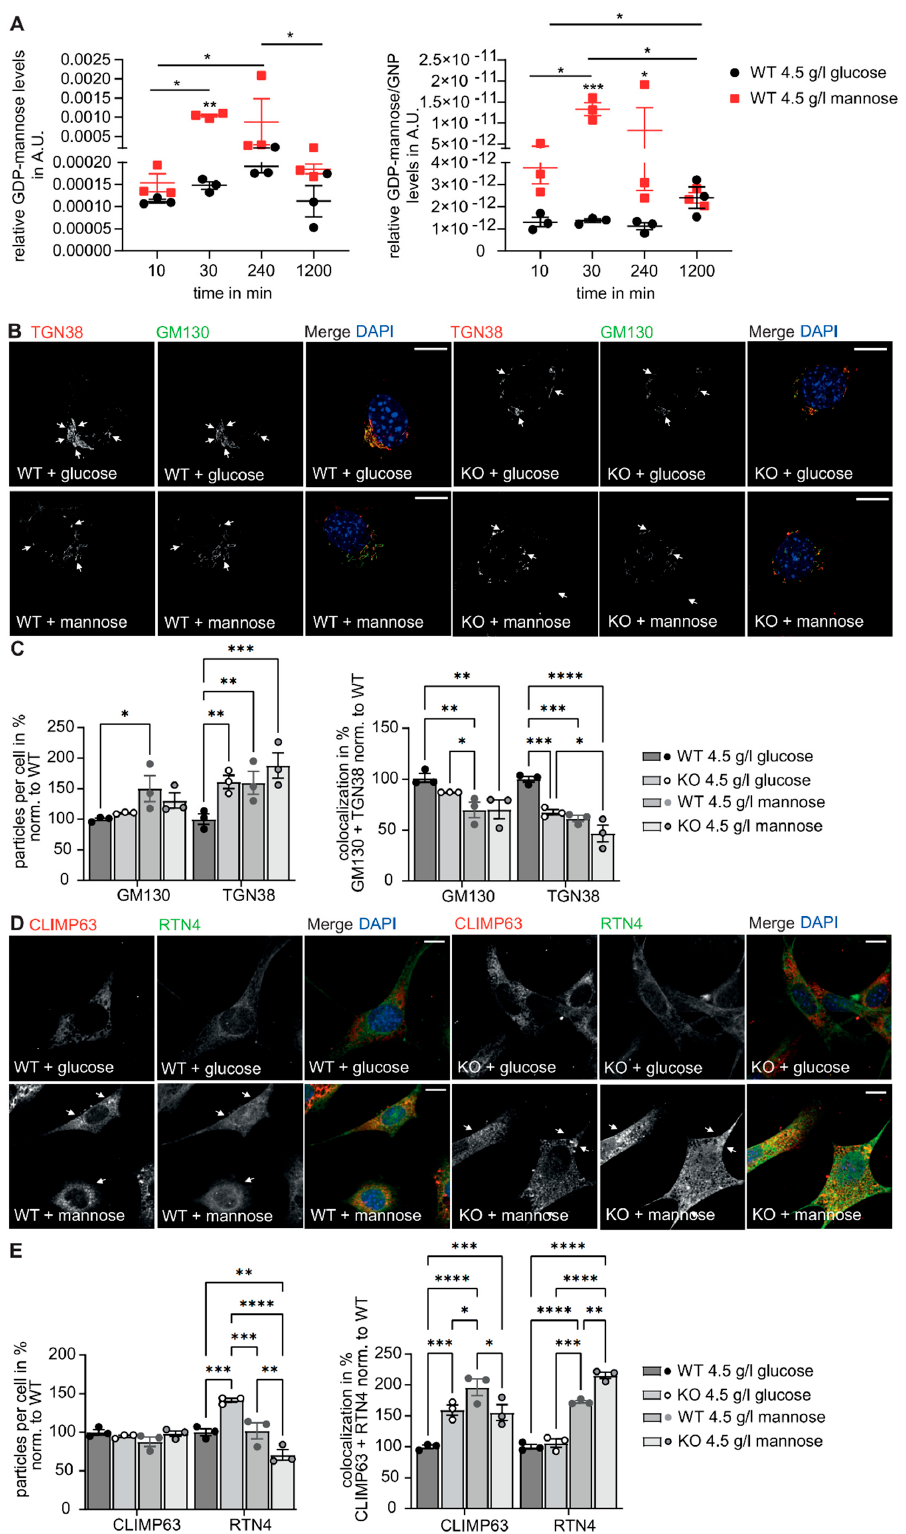
Figure 5. Effects of mannose supplementation on ER and Golgi morphology. ( A ) Left panel: relative GDP-mannose levels in arbitrary units (A.U.) measured in WT MEFs either cultured with 4.5 g/L glucose or mannose for different time points. Right panel: relative GDP-mannose levels in arbitrary units (A.U.) normalized to GNP levels (GMP + GDP + GTP) measured in WT MEFs either treated with 4.5 g/L glucose or mannose for different time points. ( B ) Representative images of WT